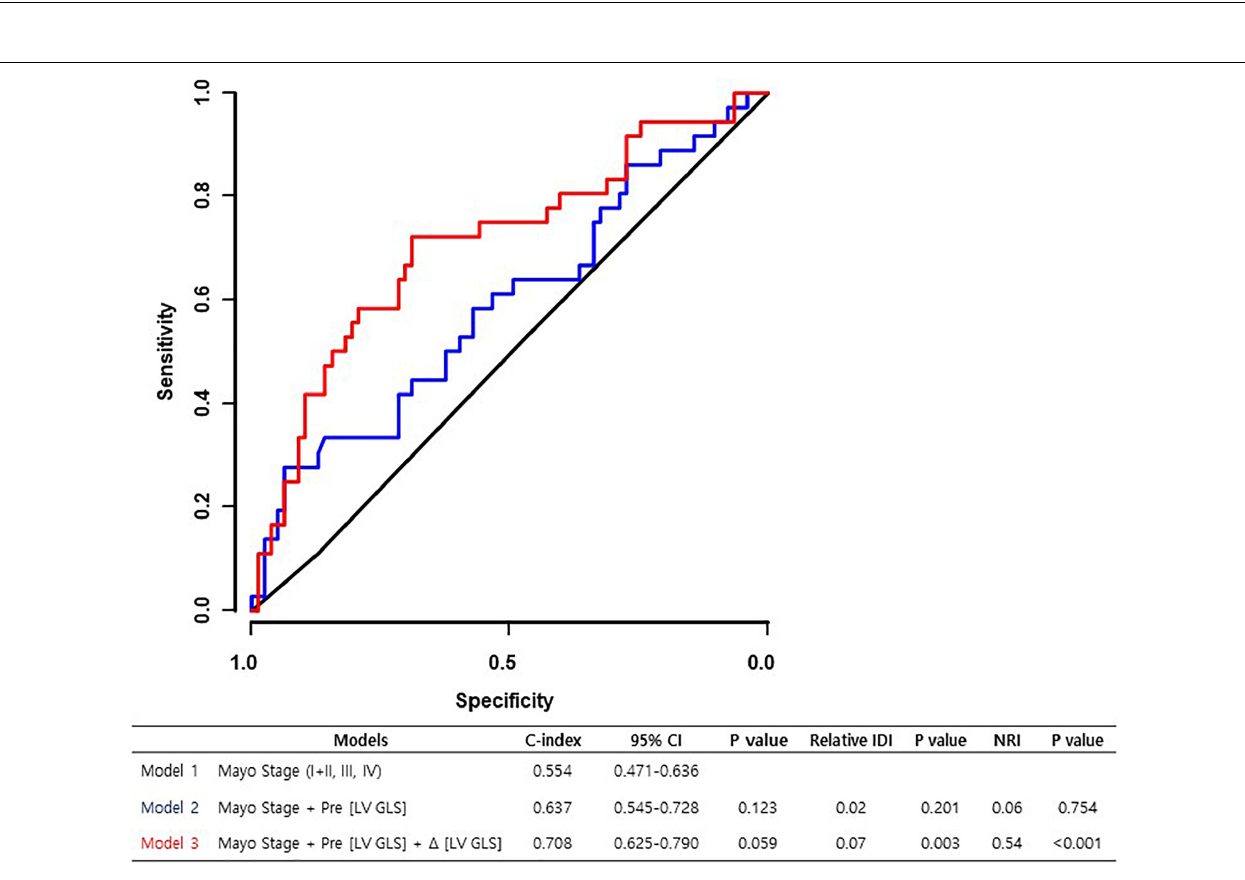
FIGURE 4 | Addictive prognostic value of (cid:49) [LV GLS] and Pre [LV GLS] in 2012 Mayo stage. C-index, harrell’s concordance index; CI, confidence interval; IDI, Integrated Discrimination Index; (cid:49) [LV GLS], Post-chemotherapy [LV GLS]—Pre-chemotherapy [LV GLS]; NRI, Net Reclassification Improvement; Pre [LV GLS], Pre-chemotherapy [LV